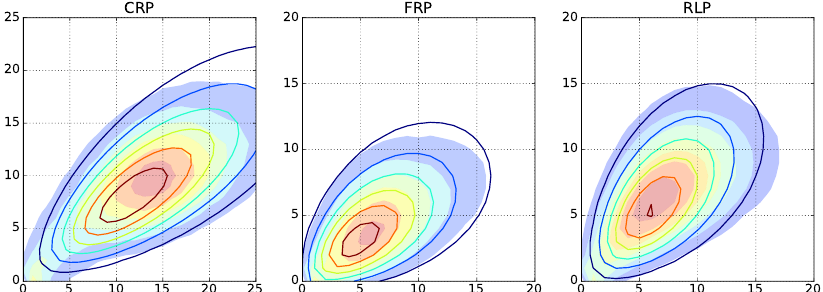
Figure 5. Filled contours: copolymer fingerprints of the Monte Carlo simulations of controlled radical polymerization (CRP, left ), free radical polymerization (FRP, center ), and reversible living polymerization (RLP, right ) with the highest used termination and propagation reaction rates of 0.1. Contours: fingerprints computed by the model with the best parameters resulting from the optimizations using the ODE fingerprint-generating function.